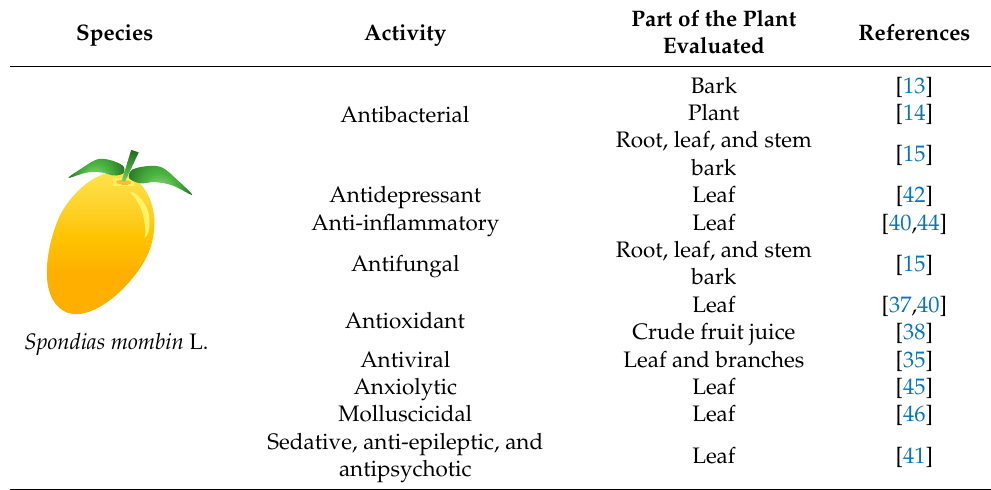
Table 1. Summary of Spondias mombin L. activity in different parts of the plant, as described in the last few years.